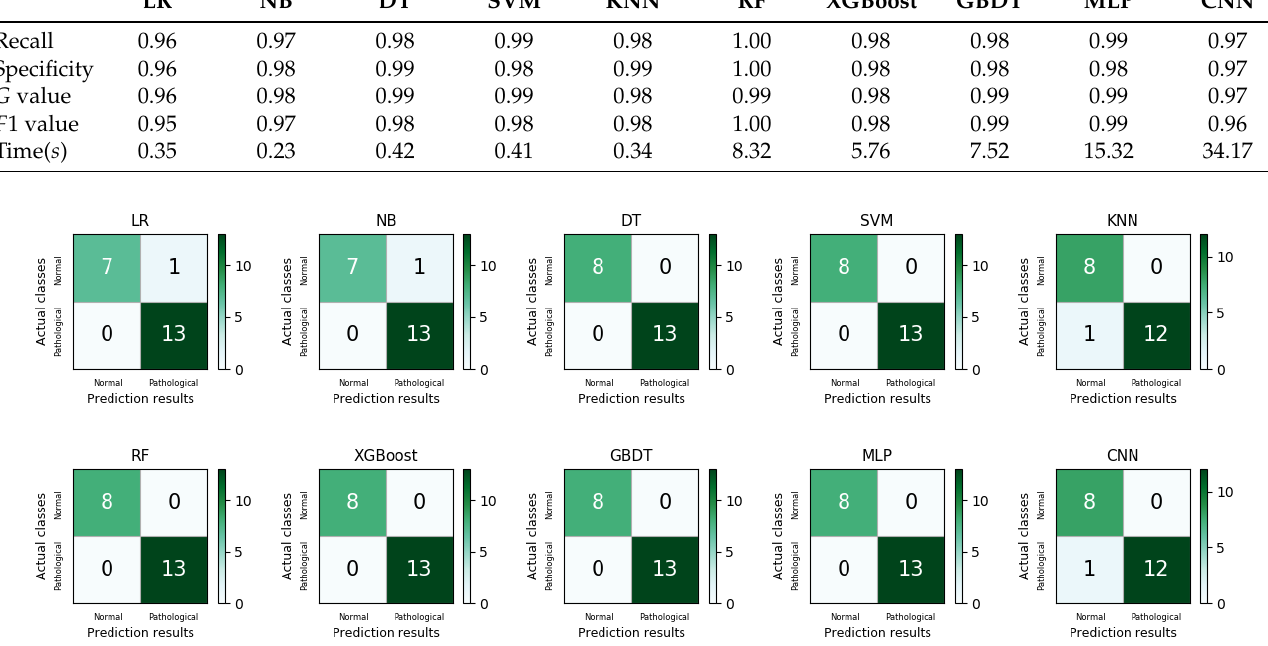
Figure 7. The binary classification confusion matrices of LR, NB, DT, SVM, KNN, MLP, and RF in the class-balanced